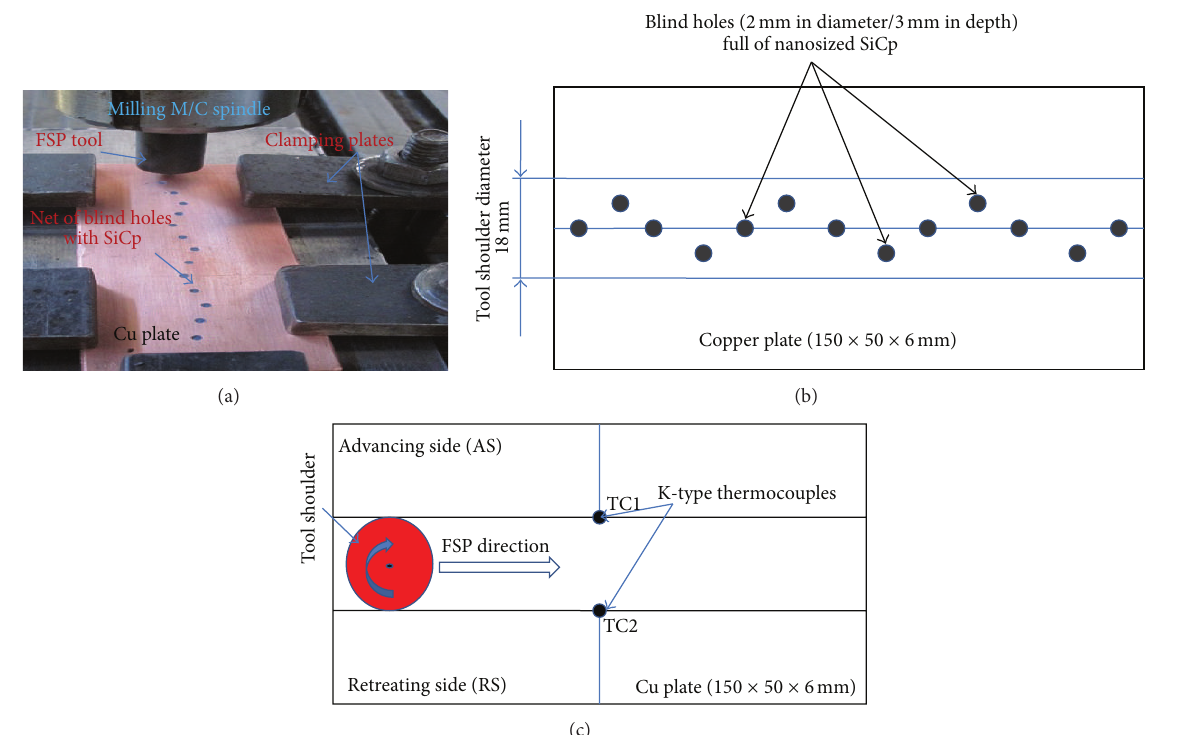
Figure 2: (a) Experimental setup, (b) design of blind holes on Cu plate, and (c) thermocouple